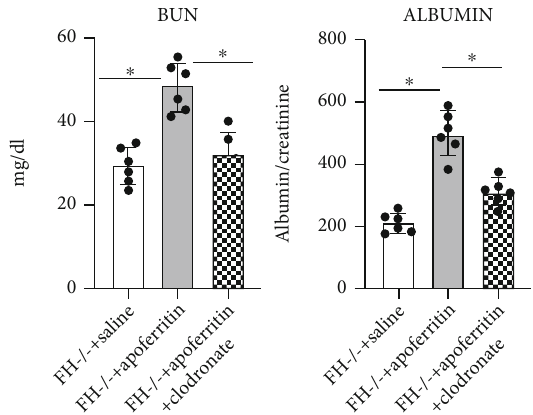
Figure 4: M ϕ depletion prevents reduced kidney function in FH- dependent ICGN. Shown are fi nal blood urea nitrogen (BUN) and albumin concentrations from fH -/- mice treated with saline (control), apoferritin (ICGN), or apoferritin+clodronate. Each circle is from an individual animal. ∗ P = 0 : 015 versus the control.